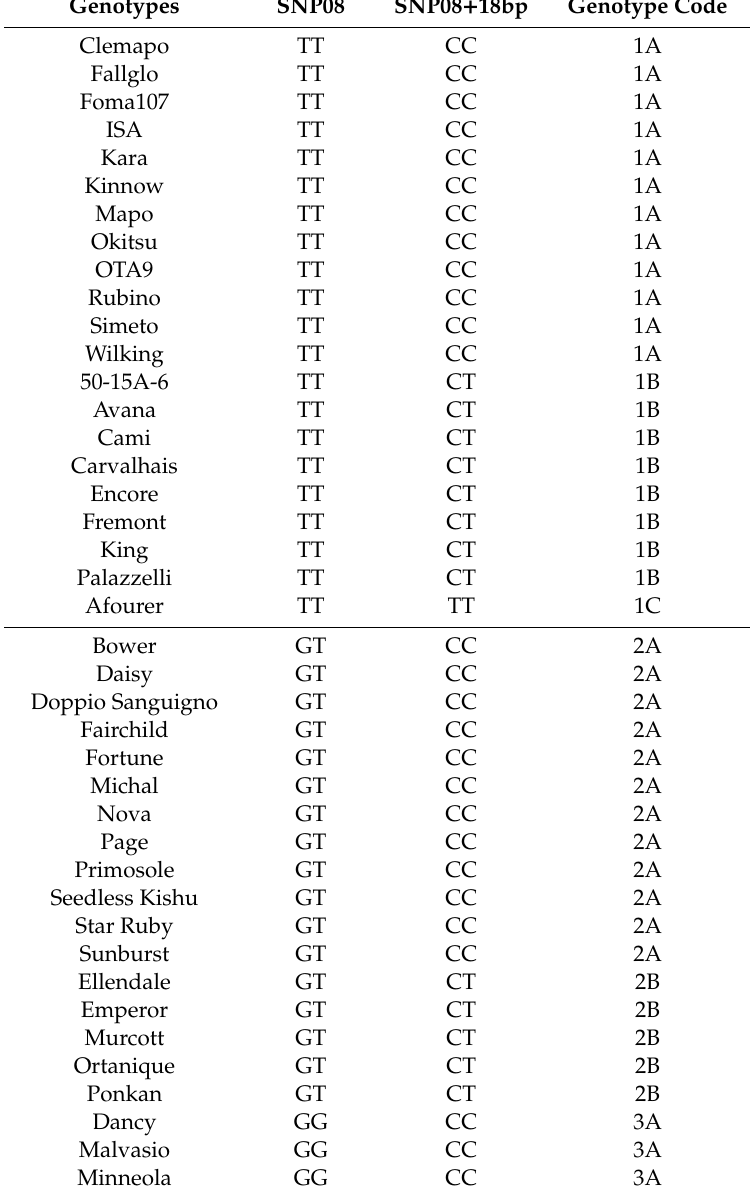
Table 3. Genotypes of 41 accessions of CREA germplasm collection at the locus surrounding the SNP08, based on HRM and Sanger